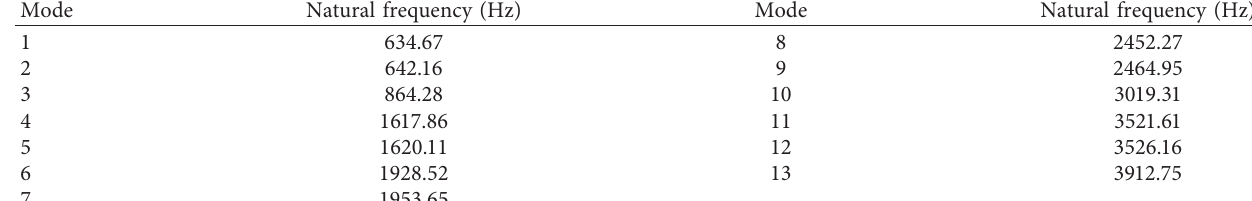
Table 7: Natural frequencies of cover obtained from the experiment.